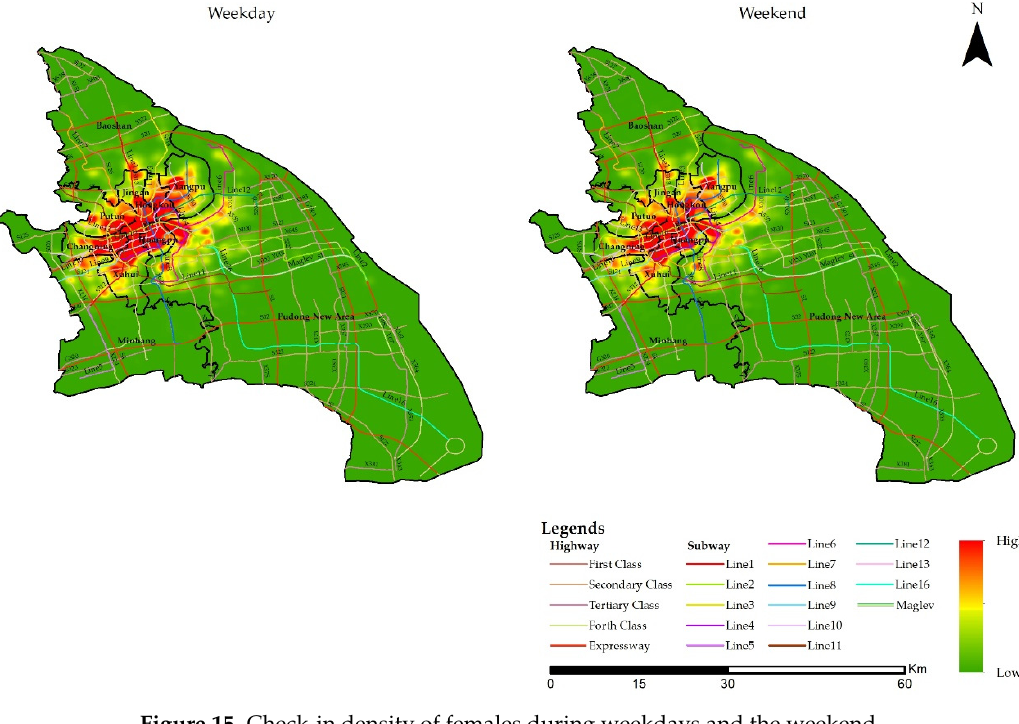
Figure 15. Check ‐ in density of females during weekdays and the weekend.